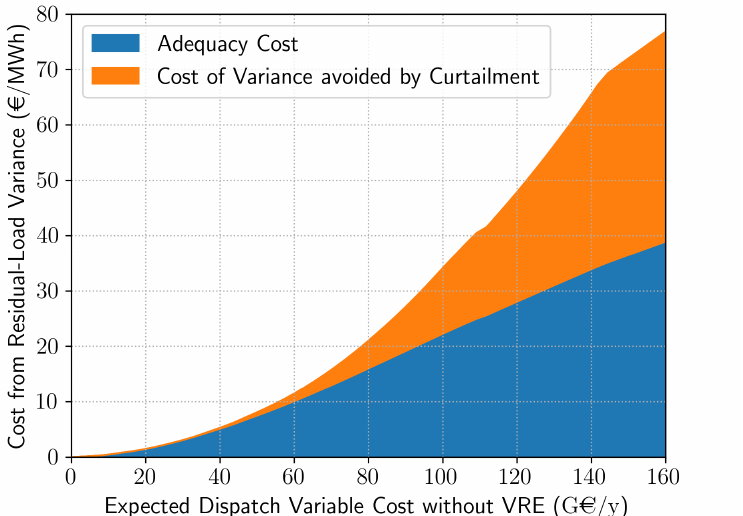
Figure 10. Average variable dispatch cost due to the variance of the residual load with (blue) and without (orange) the reduction by